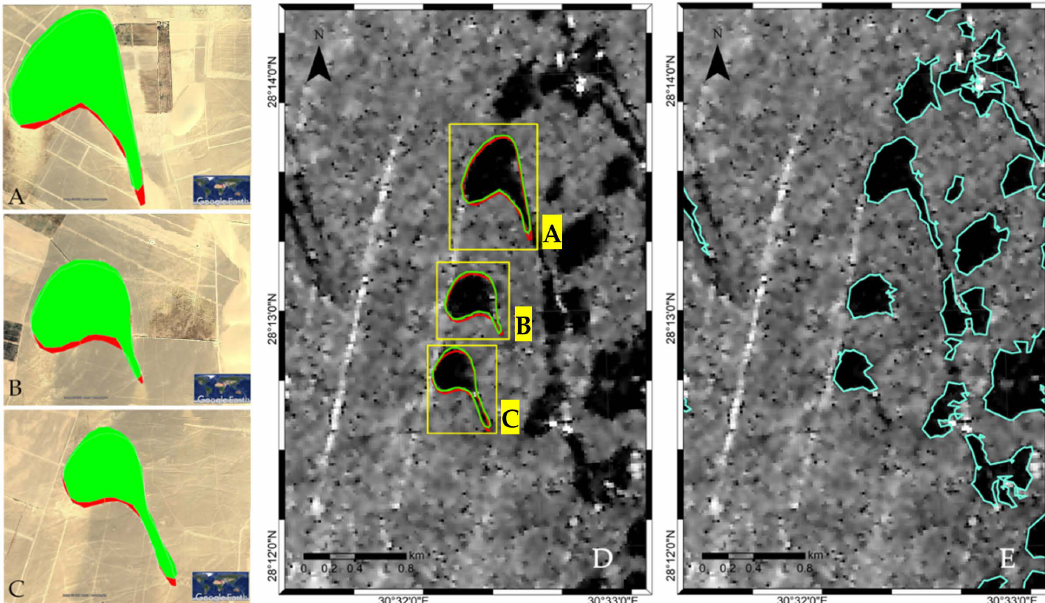
Figure 14. ( A – C ) shows the delineated dunes in green for 2007 and red for 2010. ( D ) (middle) shows the Envisat SAR image for 2010 as its background, overlaid with the outline polygons of the manually delineated dunes within the yellow rectangles. ( E ) (right) shows the Envisat SAR image for 2010 as its background, overlaid with the outline polygons of the detected dunes using the automatic approach. Table 5. Dune information extracted from the manually delineated dunes in Google Earth in 2007 and 2010, located in the South Rayan dune field. Heading Id. Dune